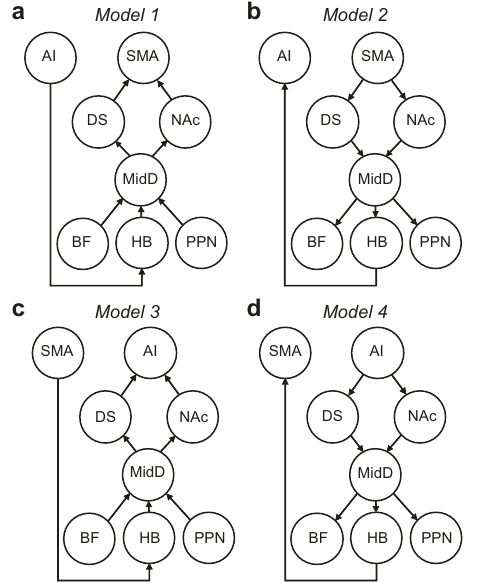
Fig. 6 Willingness-to-act emerges across a multi-layered network. a The hypothesised functional model in which activity in the supplementary motor area (SMA) is in fl uenced by dorsal striatum (DS) and nucleus accumbens (NAc). Activity in DS and NAc is, in turn, in fl uenced by dopaminergic midbrain (MidD). Activity in MidD is in fl uenced by basal forebrain (BF), pedunculopontine nucleus (PPN) and habenula (HB); and anterior insula (AI) in fl uences HB (for estimates of path coef fi cients, see Supplementary Table S4). b − d Alternative models. The hypothesis-driven model (Model 1) fi ts the data better than the alternative models (Models 2 −